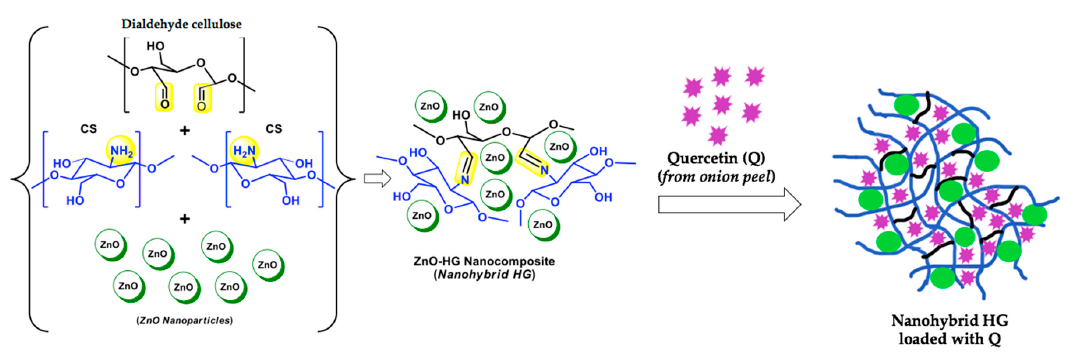
Figure 2. Schematic representation of the nanocomposite hydrogel (HG) developed by George D, et al. [42]; base polymer formed by chitosan (CS; drawn in blue) cross-linked with dialdehyde cellulose (drawn in black) via Schiff base formation (highlighted in yellow). ZnO nanoparticles marked in green and quercetin (Q; from onion peel waste) marked in purple.